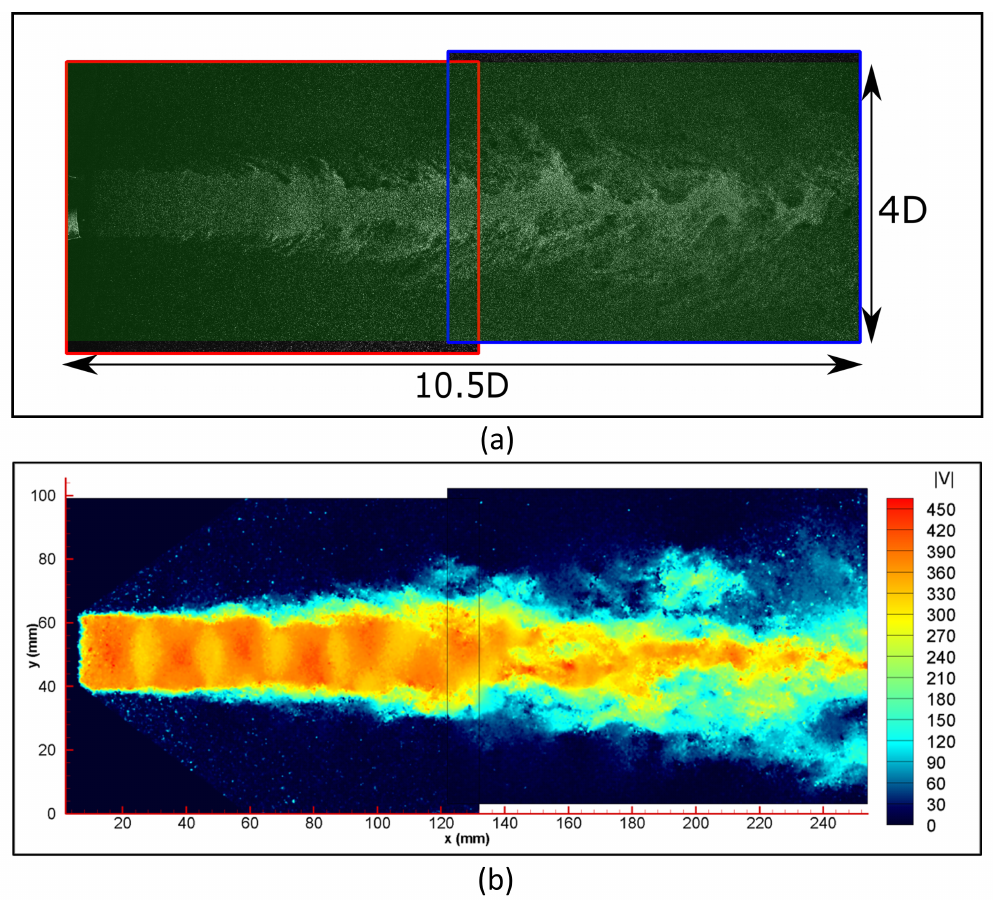
Figure 16. ( a ) Example of instantaneous combined FOVs and ( b ) instantaneous velocity field post-processed using a 12 × 12 pixels 2 final window with 75% overlap for CNPR = 2.50. The flow field shows a system of five shock-cells in line, with the sixth and the seventh one oscillating in antisymmetric